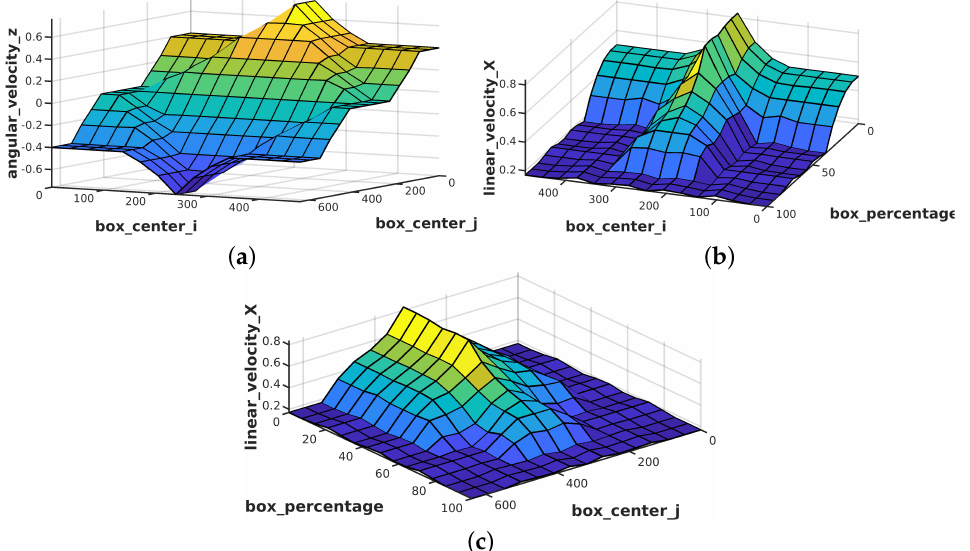
Figure 13. System’s surface behavior. ( a ). Centering the robot’s angle concerning the trap. ( b ) and ( c ) Equipment linear speed in the x _ axis